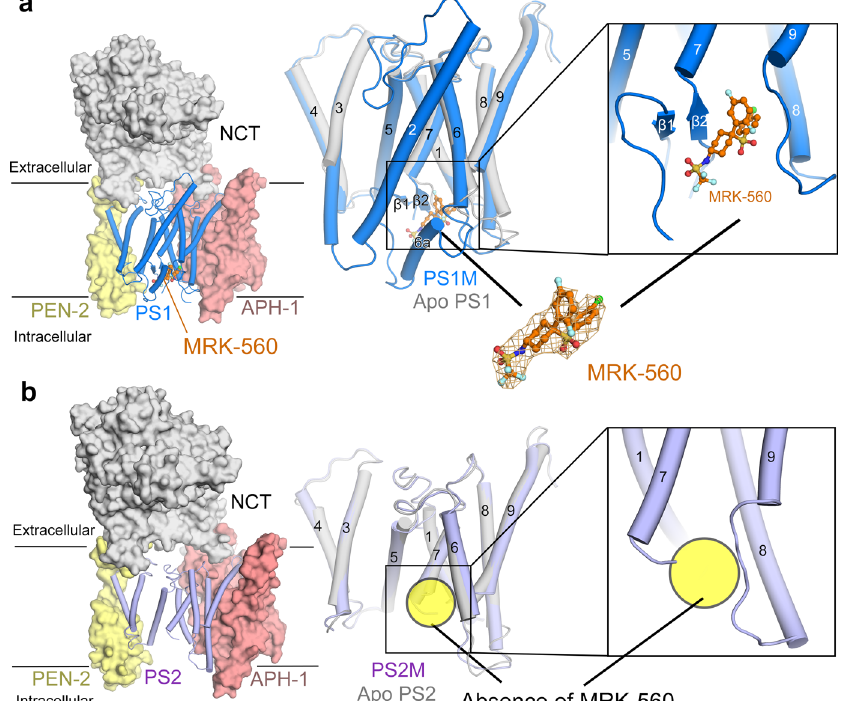
Fig. 2|MRK-560 isobservedinthePS1-complex,but notPS2.a Overallcryo-EM structure of the human PS1-complex bound to MRK-560. MRK-560 is shown as orangeballadsticks.PS1inthepresenceofMRK-560iscoloredmarine(leftpanel), whichis alignedwith PS1infree state (middle panel).The chlorophenyl(CP)group and the di fl uorobenzyl (DFB) group of MRK-560 insert deeply into the binding cavity. The tri fl uoromethanesulfonamide (TFMS) group points towards the